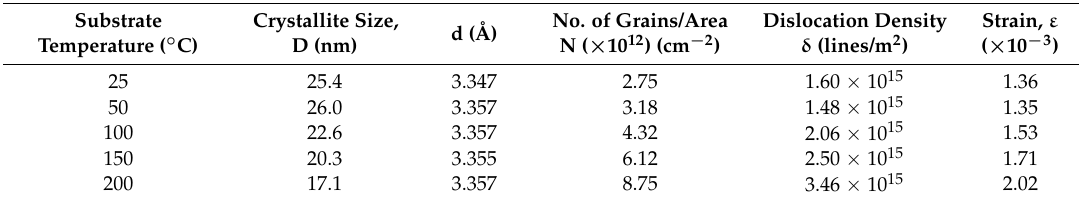
Table 1. Structural parameters of CdS thin